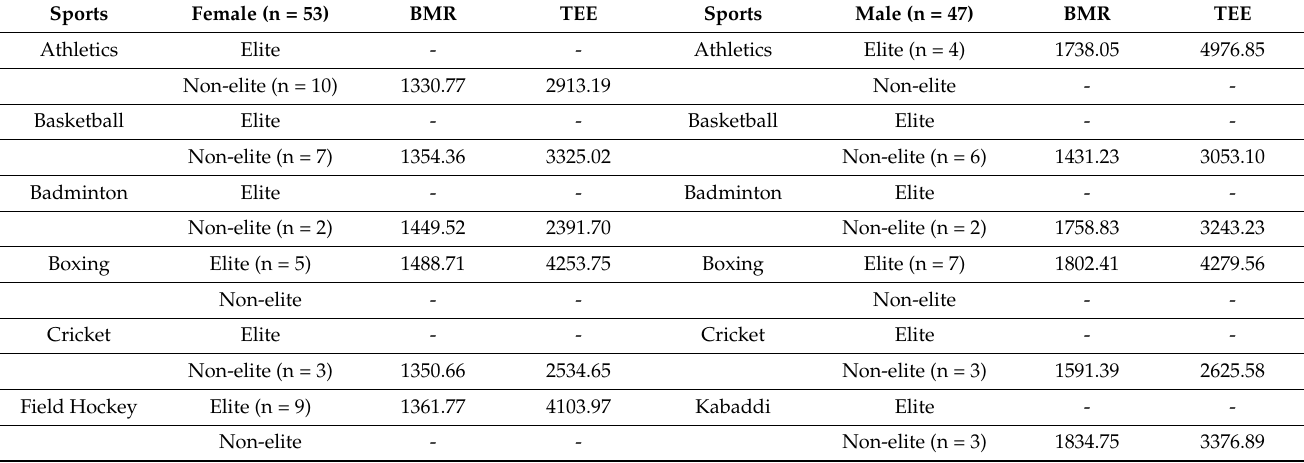
Table 2. Physical contour of elite and non-elite athletes of different sports (n = 100) .